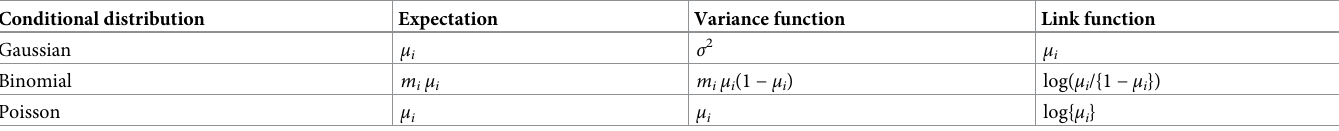
Table 1. Summary of the generalized linear geostatistical model distributions implemented in MBGapp: The conditional distribution of Y i given the random effects S ( x i ) and Z i , including its expectation, variance function and link